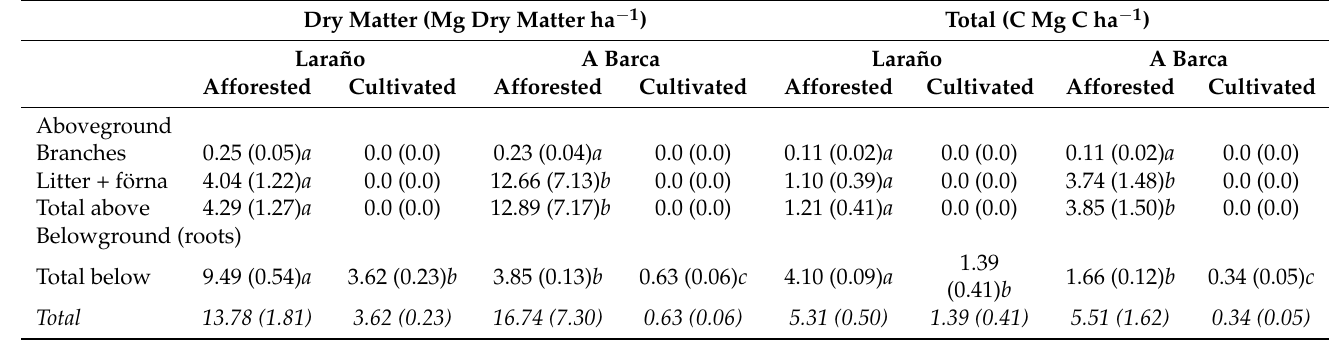
Table 5. Dead organic matter stock (Mg ha − 1 ). Values are means and standard deviation, in brackets (n = 3). Different letters indicate significantly different mean values between sites ( p < 0.05).